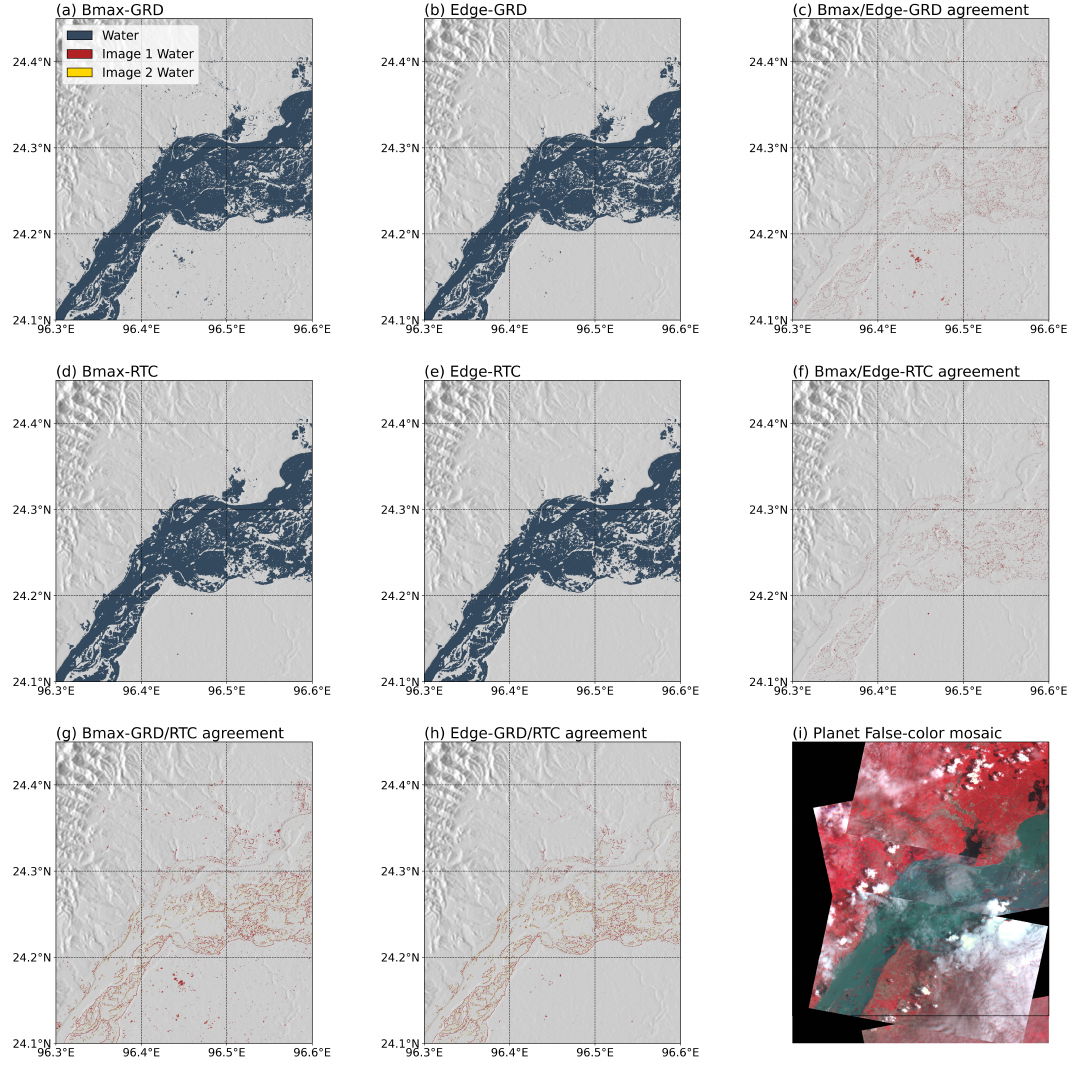
Figure 6. Same as Figure 5 except highlighting surface water maps over the Irrawaddy river in Myanmar for